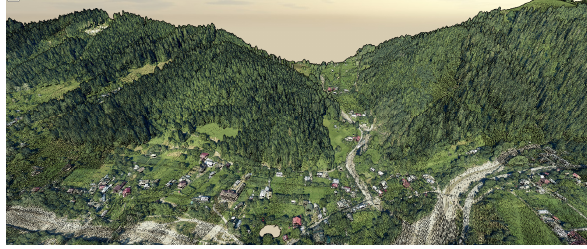
Figure 23 . LiDAR point clouds fused with RGB information from Open Skies images (orthophotoplans)